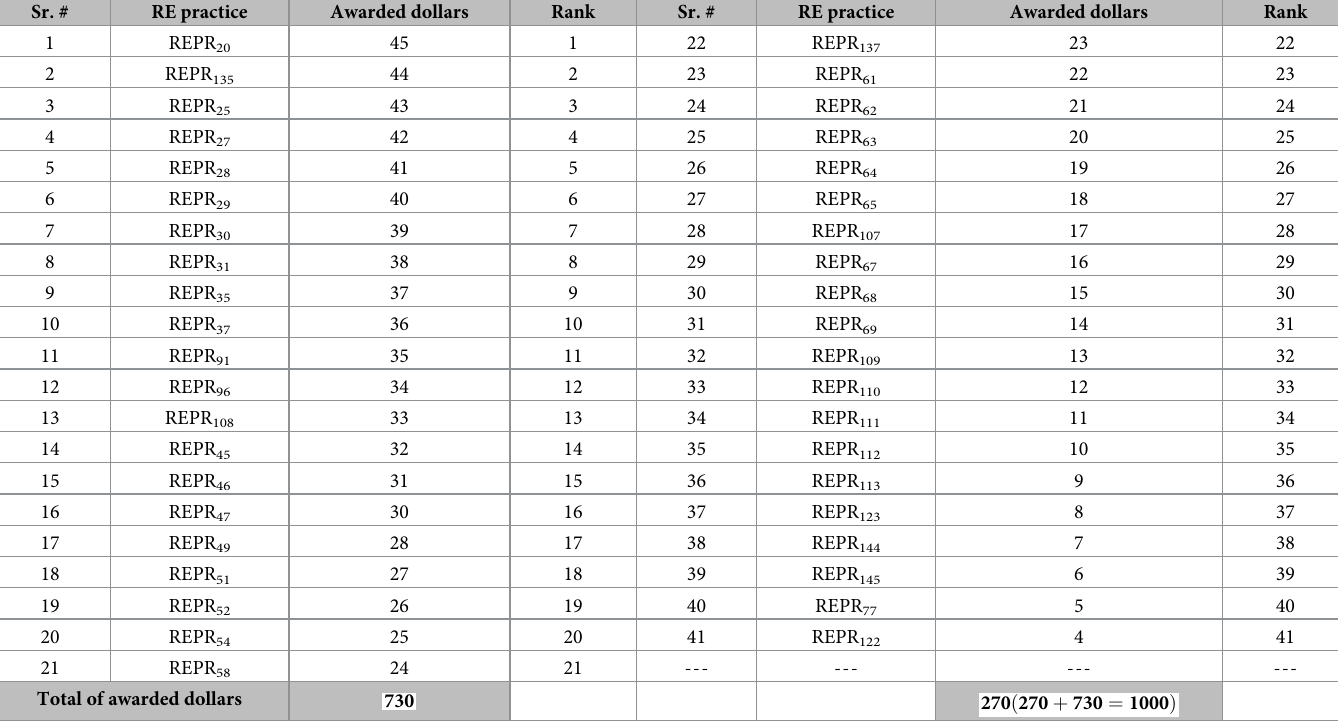
Table 6. RE Practices belonging to ‘Medium’ importance group along with respective ranks within